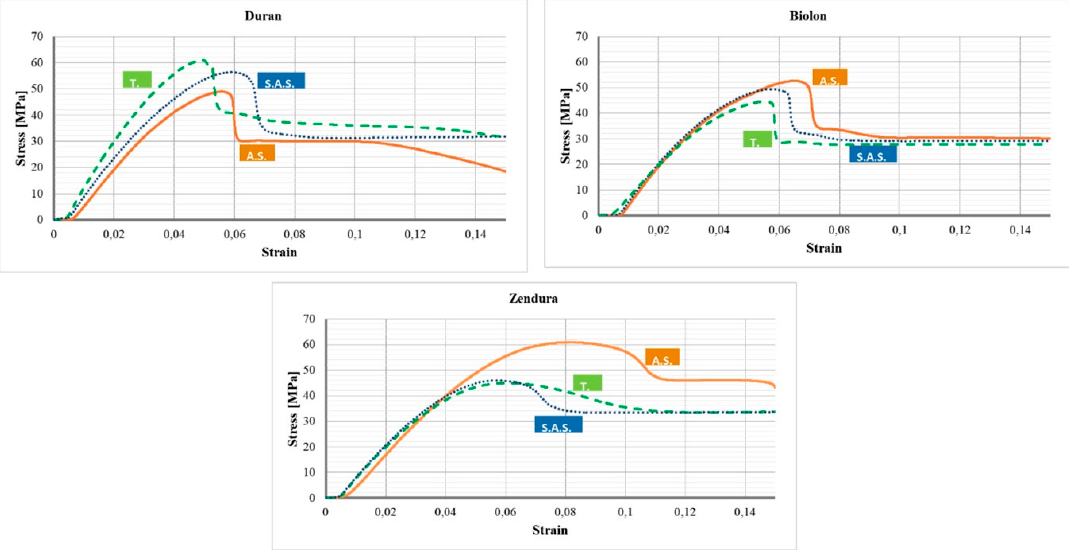
Figure 5. Representative stress-strain curves of Duran, Biolon and Zendura specimens: A.S., T., S.A.S.